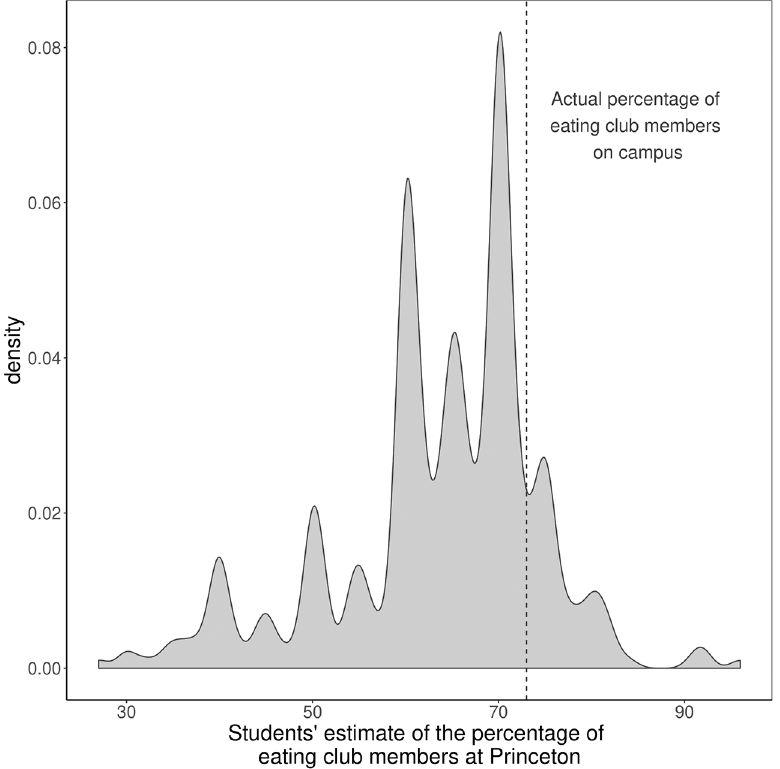
Figure 1. Density of the students’ estimate of the proportion of eating club members. The vertical dashed line represents the actual proportion of eating club members on